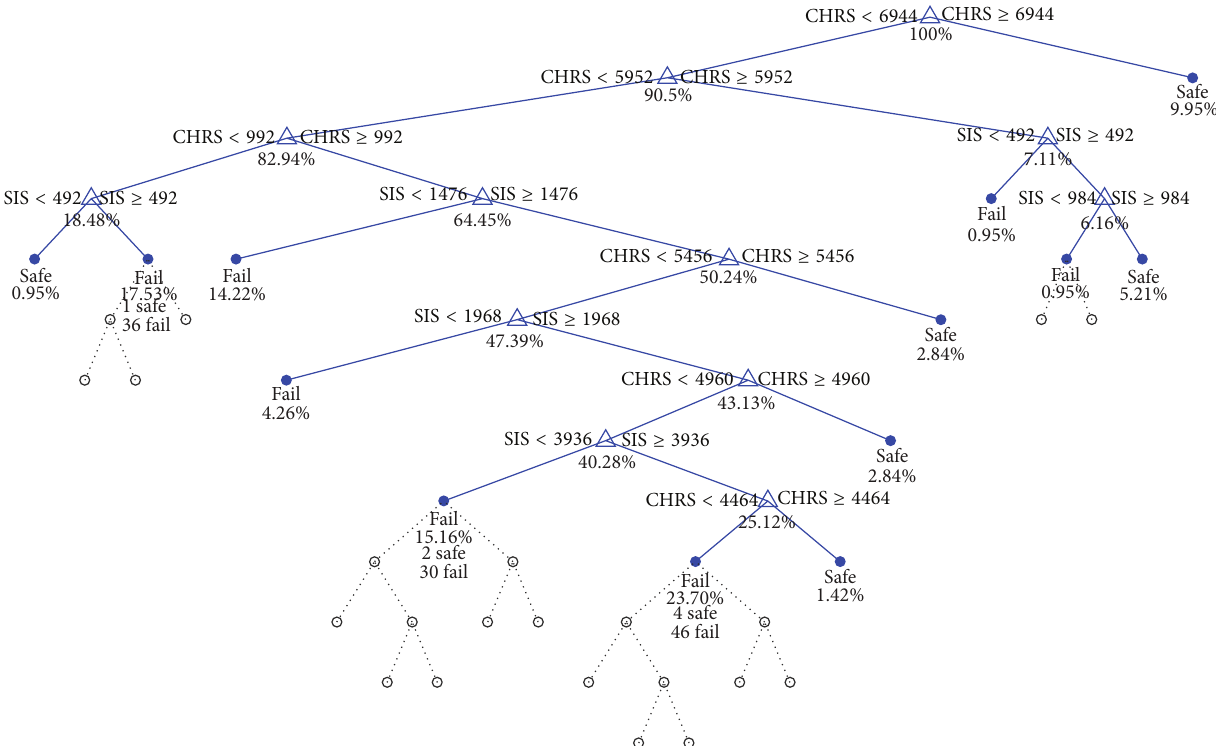
Figure 14: Decision tree fitted into clustering results data for the sequence [ INI SIS CHRS IGNI ] (sec) for controllable variables.